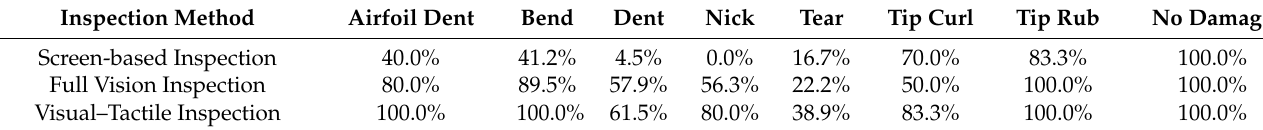
Table 8. Defect classification accuracy of each inspection method by defect type.